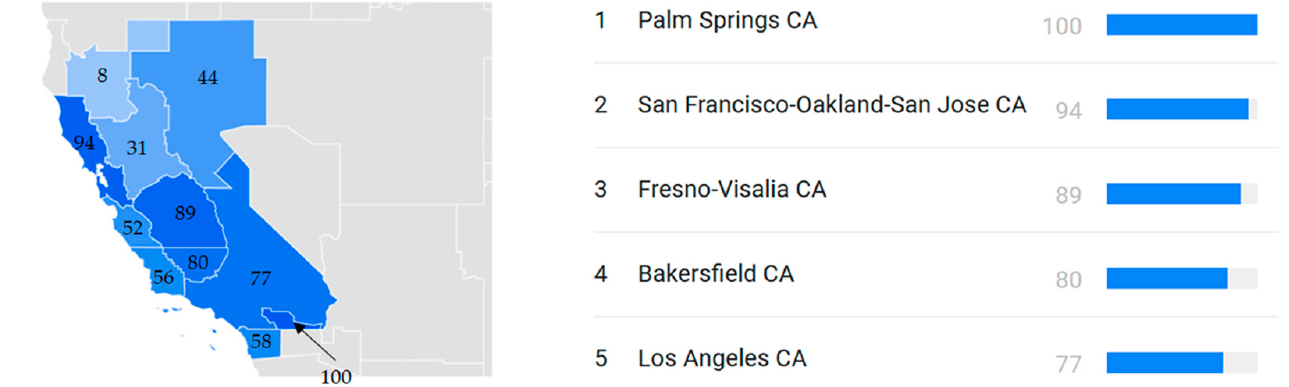
Figure 3. GeoMap of interest for earthquake insurance in California metropolitan areas over the entire time span (2004–2021, GeoMap modified from the original).